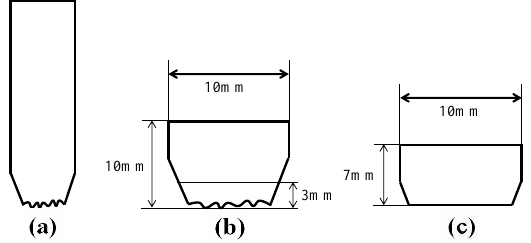
Table 1. Chemical composition of two experimental steels and Q345B (wt.%).